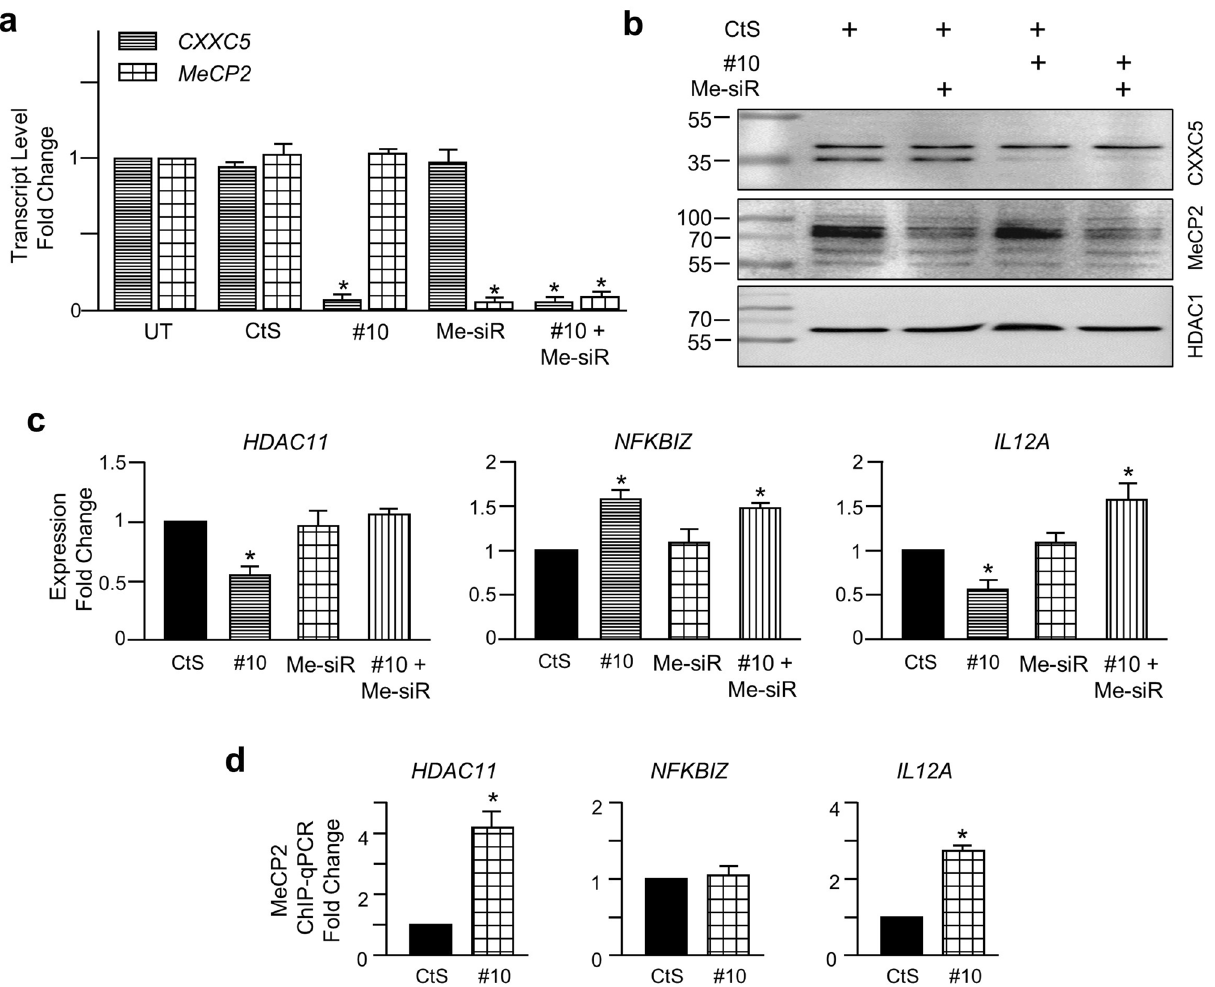
Figure 8. Assessing the interplay between CXXC5 and MeCP2 in CXXC5 target gene expressions. ( a ) MCF7 cells were untransfected (UT), or were transiently transfected with CtS, siRNA specific for CXXC5 (#10), and/or siRNA pool for MeCP2 (Me-SiR) for 48 h. To equalize the total amount of siRNA (20 nM) used in co-transfection experiments, 10 nM gene-specific siRNA was used together with 10 nM CtS. cDNA generated from total RNA were subjected to qPCR. The RPLP0 expression was used for normalization. Results, the mean ± S.E. of three independent determinations, depict fold change in comparison with transcript levels of CXXC5 or MeCP2 of UT, which were set to 1. The asterisk indicates a significant difference. ( b ) Nuclear extracts of transfected cells were also subjected to WB using the CXXC5 or MeCP2 antibody. HDAC1 was probed with an HDAC1-specific antibody. MMs in kDa are indicated. Uncropped blots are presented in Supplementary Information, Figure S11. ( c ) To assess the effect of reduction in CXXC5 and/or MeCP2 levels on gene expressions, MCF7 cells were transfected with CtS, #10, and/or Me-SiR as indicated for 48 h. cDNAs were then subjected to qPCR using primer sets specific to target genes. RPLP0 expressions were used for normalization. Results as fold change in gene expressions compared to those observed in CtS transfected cells are the mean ± S.E. of three independent determinations. Asterisks indicate significant differences. ( d ) To assess whether alterations in CXXC5 levels affect the MeCP2 loading on target promoters, MCF7 cells transfected with CtS (10 nM) or #10 (10 nM) for 48 h were subjected to ChIP using IgG or a MeCP2 antibody. Recovered DNAs were subjected to qPCR using primer sets for target gene promoters. Results, normalized to IgG, depict fold changes compared to CtS, which was set to NFKBIZ , or IL12A in MCF7 cells transiently transfected with a control siRNA (CtS), a siRNA specific to CXXC5 (#10), and/or a siRNA pool specific to MeCP2 (Me-siR). Results revealed that CtS did not affect the transcript or protein levels of CXXC5 or MeCP2. #10 specifically repressed the transcript and protein levels of CXXC5 without affecting those of MeCP2 (Fig. 8a,b; Supplementary Information, Fig. S11). Re-probing the membrane with an antibody specific to MeCP2, which also immunoprecipitates endogenous MeCP2 in MCF7 cells (Supplementary Information, Fig. S12), indicated that Me-siR specifically suppressed the transcript and protein levels of MeCP2. Co-transfection of #10 and Me-siR led to suppression of the transcript and protein levels of both CXXC5 and MeCP2 (Fig. 8a,b; Supplementary Information, Fig. S11).